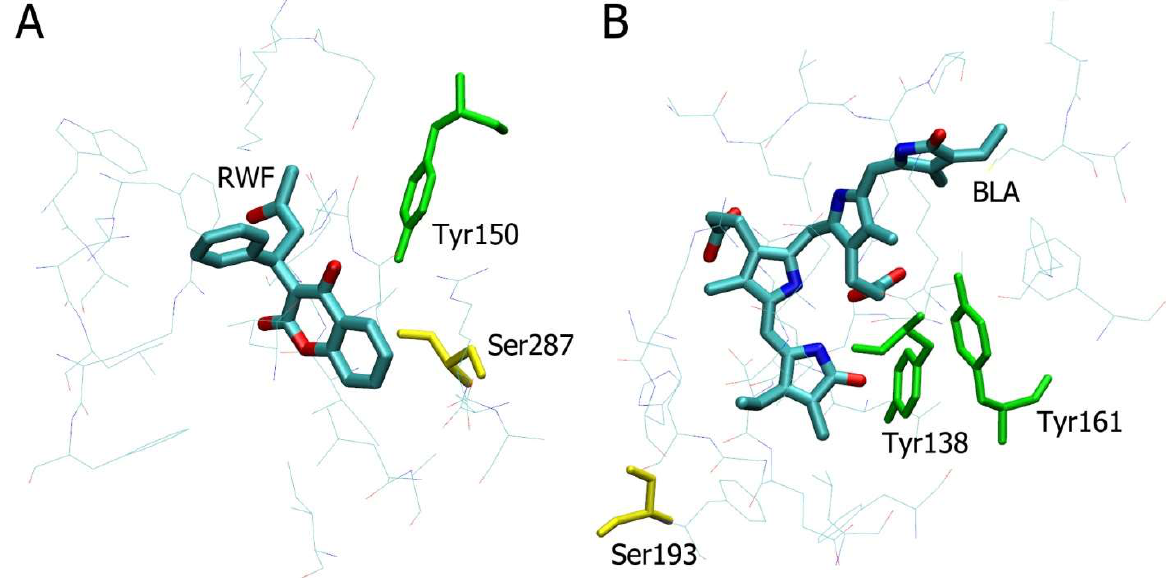
Figure 4. Sudlow site I ( A ) and site III ( B ) of human serum albumin (HSA) with bound site-specific ligands and potential catalytic amino acids. RWF, warfarin; BLA, 4Z,15E-bilirubin-IXalpha.